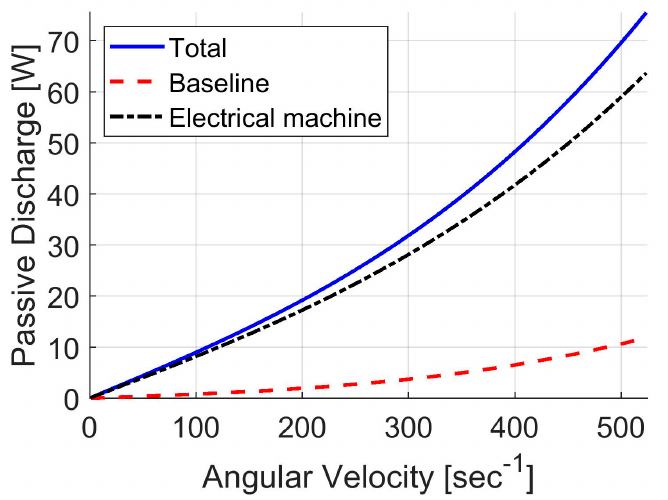
Figure 7. Predictions of the combined total passive discharge for the rotor with the coupled electri ‐ cal machine, as well as the components related to the electrical machine no ‐ load losses and the baseline case losses (intermediate vacuum level, electrical machine